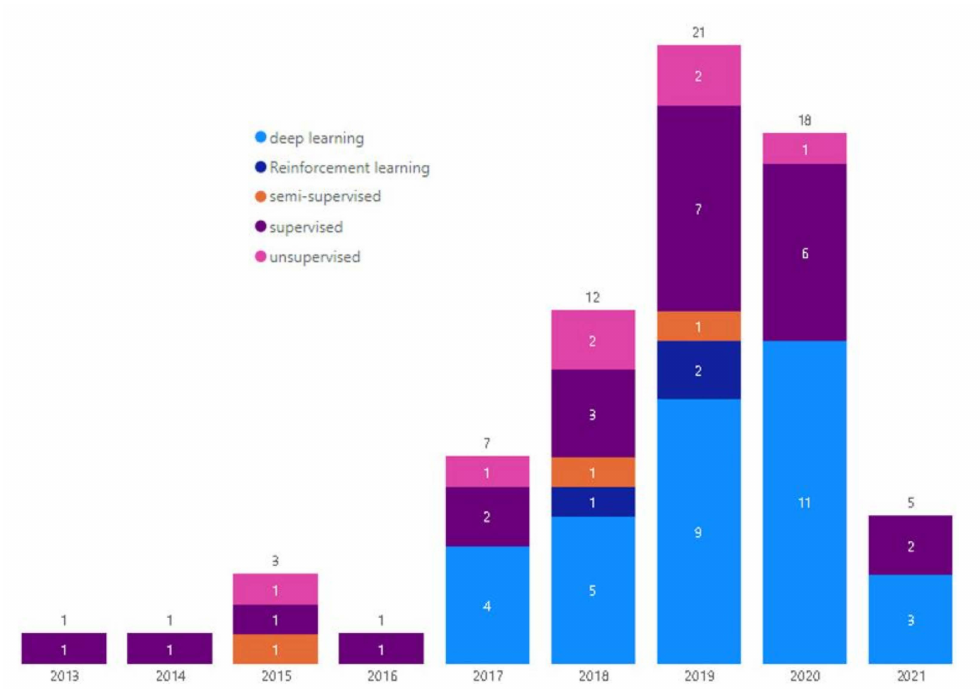
Figure 7. Machine learning techniques used in applications classified by papers’ publish year.